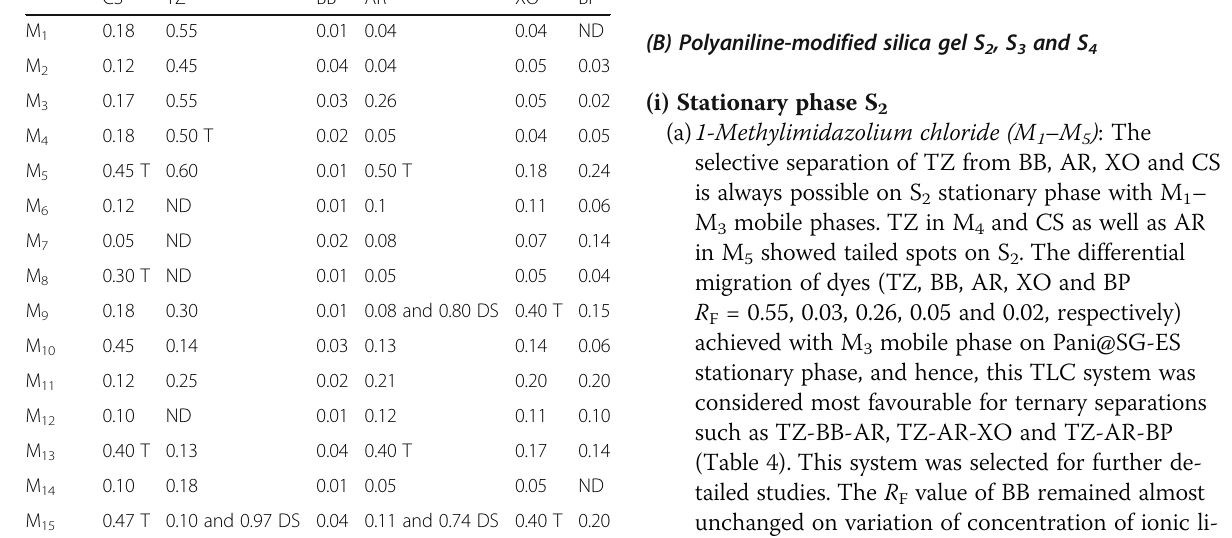
Table 4 Mobility of dyes in terms of R F values on stationary phase S 2 with different mobile phases Mobile